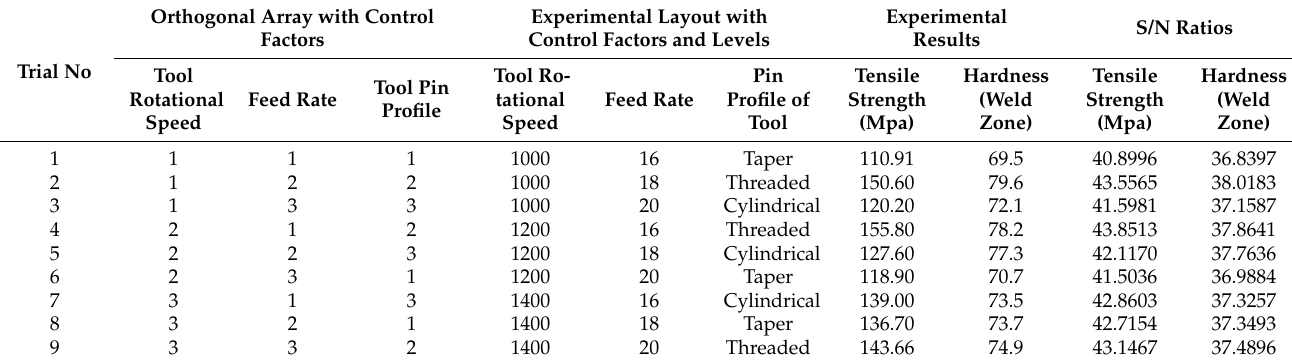
Table 4. Result of experiments and corresponding signal-to-noise